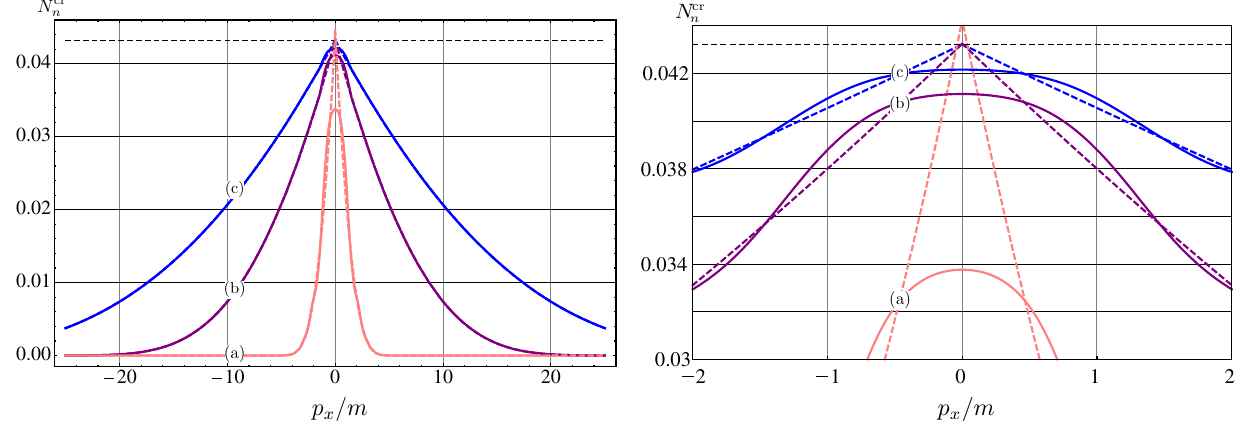
Fig. 3 Differential mean number N cr n of Bosons created by the sym- metric inverse square electric field (1), in which τ 1 = τ 2 . The exact differential mean numbers (16) are represented by blue, purple and pink solid lines while the asymptotic approximations (23), (25) are represented by dashed color lines. The right panel shows the range of